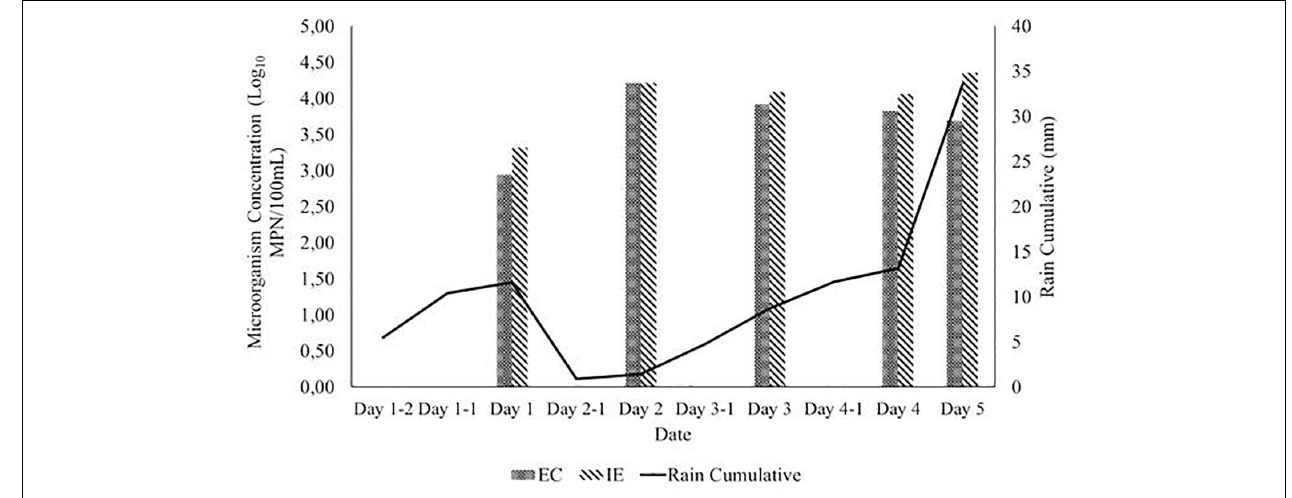
FIGURE 3 | Mean concentration of EC and IE per rain event: Day X-2 represents the rain intensity.